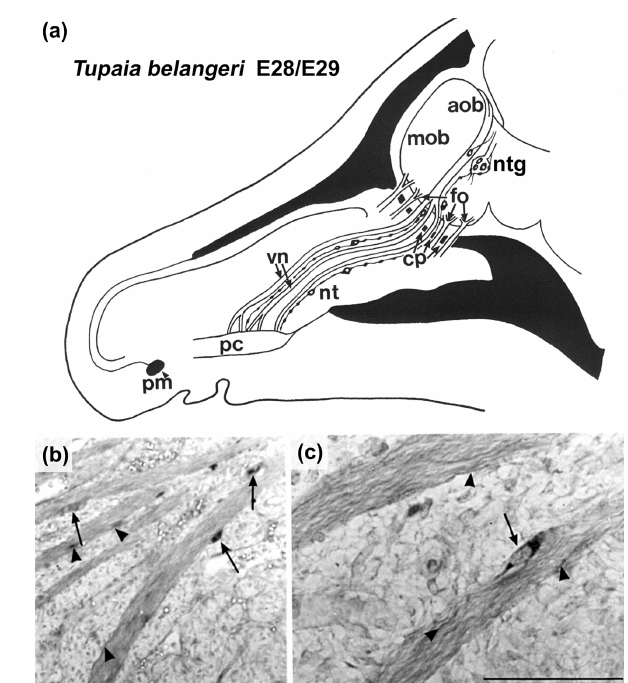
Figure 11. FMRFamide immunoreactivity in the developing ter- minal nerve of Tupaia belangeri . (a) Scheme of the vomeronasal system (right half of the head, nasal septum removed, embryonic day (E) 28/29). The vomeronasal organ is situated in the parasep- tal cartilage (pc) and sends the vomeronasal nerve (vn) through the cribriform plate (cp) to the accessory olfactory bulb (aob). The main olfactory bulb (mob) is targeted by the fila olfactoria (fo). FMRFamide-immunopositive nervus terminalis neurons (nt) reside in the vomeronasal nerve and in the nervus terminalis ganglion (ntg). pm, premaxillary bone. (b, c) Immunopositive neurons (ar- rows) and nerve fibers (arrowheads) in the terminal nerve of E28 Tupaia. Scale bars = 50µm. Reprinted from Malz and Kuhn (2002, Fig. 2). © 2002, with permission from